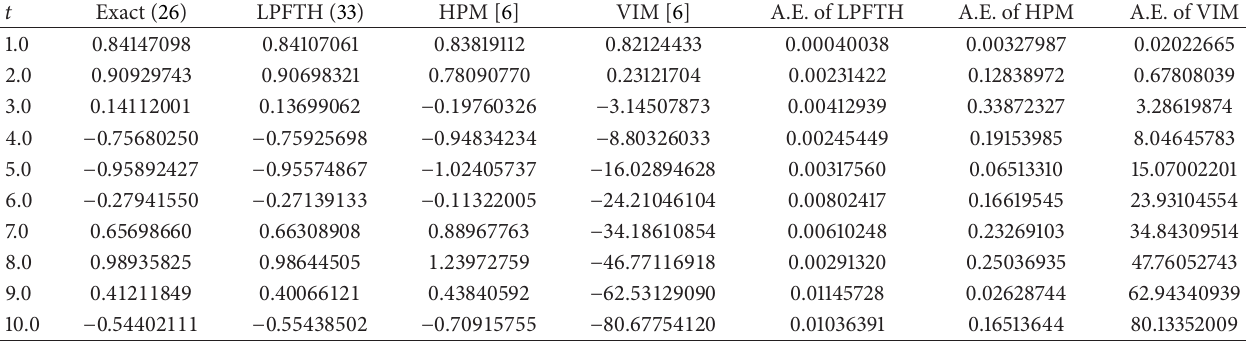
Table 1: Comparison between exact solution (26) for (25) and the results of approximations: LPFTH (33), HPM [6], and VIM [6] (A.E. means absolute error).